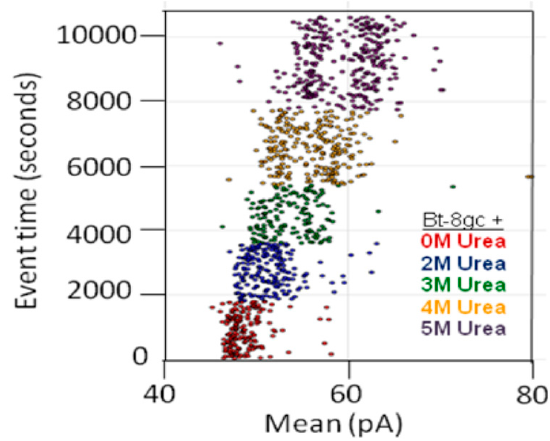
Figure 5. Transducer blockade event in increasing urea concentration. Sufficiently strong Urea concentration (5 M) results in racemization of the two loop capture-variants, while weaker urea (<2 M) does not. The results show Bt-8gc measurements at 30 min intervals (1800 s on vertical axis) with urea concentration 0, 2, and 3 M, 45 min at 4 M, and 60 min at 5 M, with signal blockade mean on the x-axis, with results consistent with the two-state loop hypothesis, and consistent with the observation of such in Figure 4 (see [20]) not due to zero or weak urea content but due to high strain due to mass and charge effects upon binding to the large streptavidin molecule.